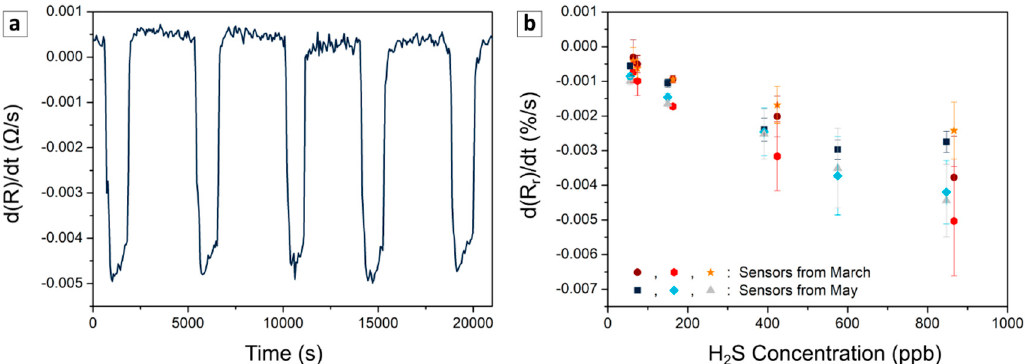
Figure 6. Repeatability and reproducibility of the sensors: derivative of the resistance as a function of time for five consecutive cycles of injection at 167 ± 9 ppb of H 2 S ( a ) and calibration curves based on the derivative of the relative response of two series of three different sensors ( b ). Each form represents different sensors produced in two batches (one in March and one in May). All the sensors contained 3 wt% of PEDOT:PSS and were studied one month after their fabrication.